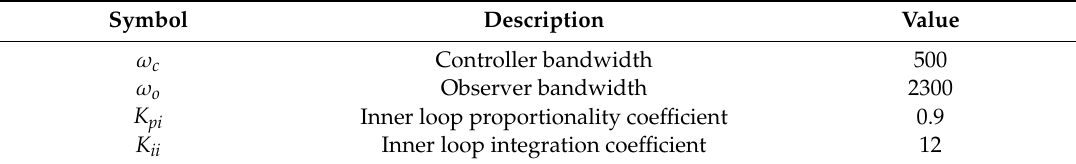
Table A2. Controller